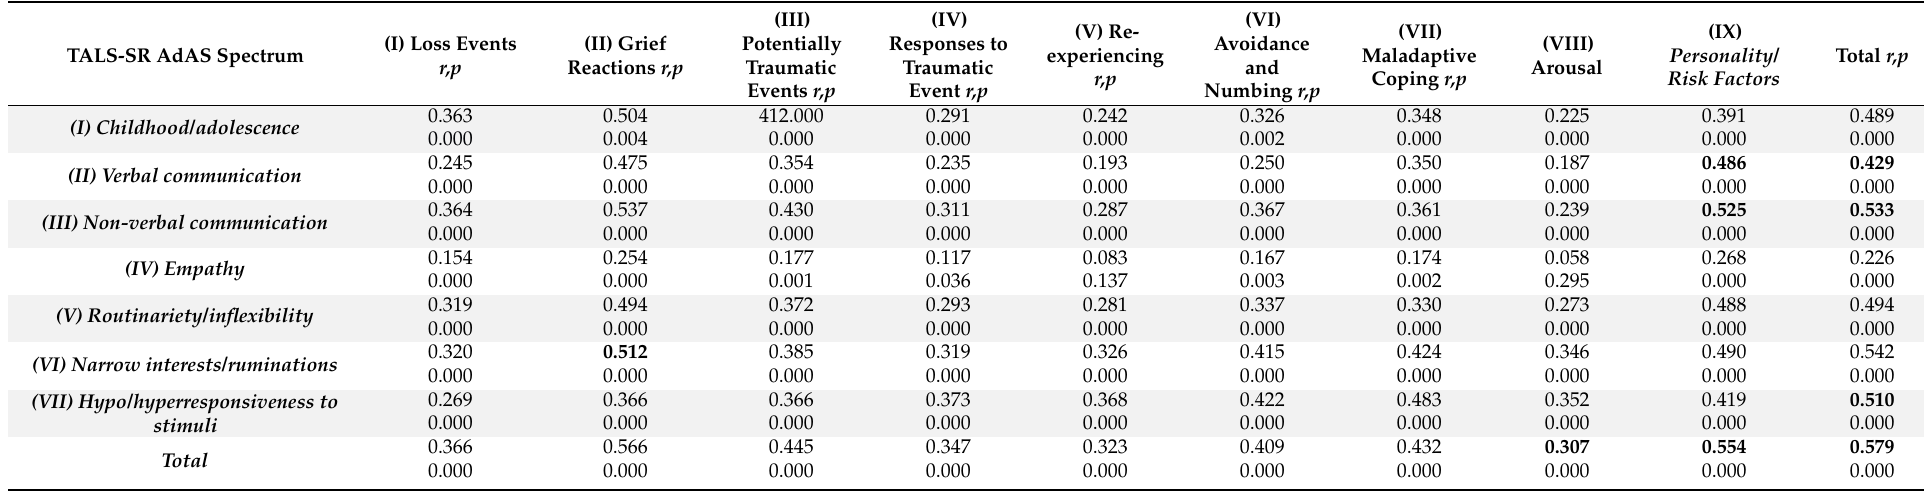
Table 4. Correlation between AdAS spectrum and TALS-SR total and single domain scores in the total sample (N = 323).